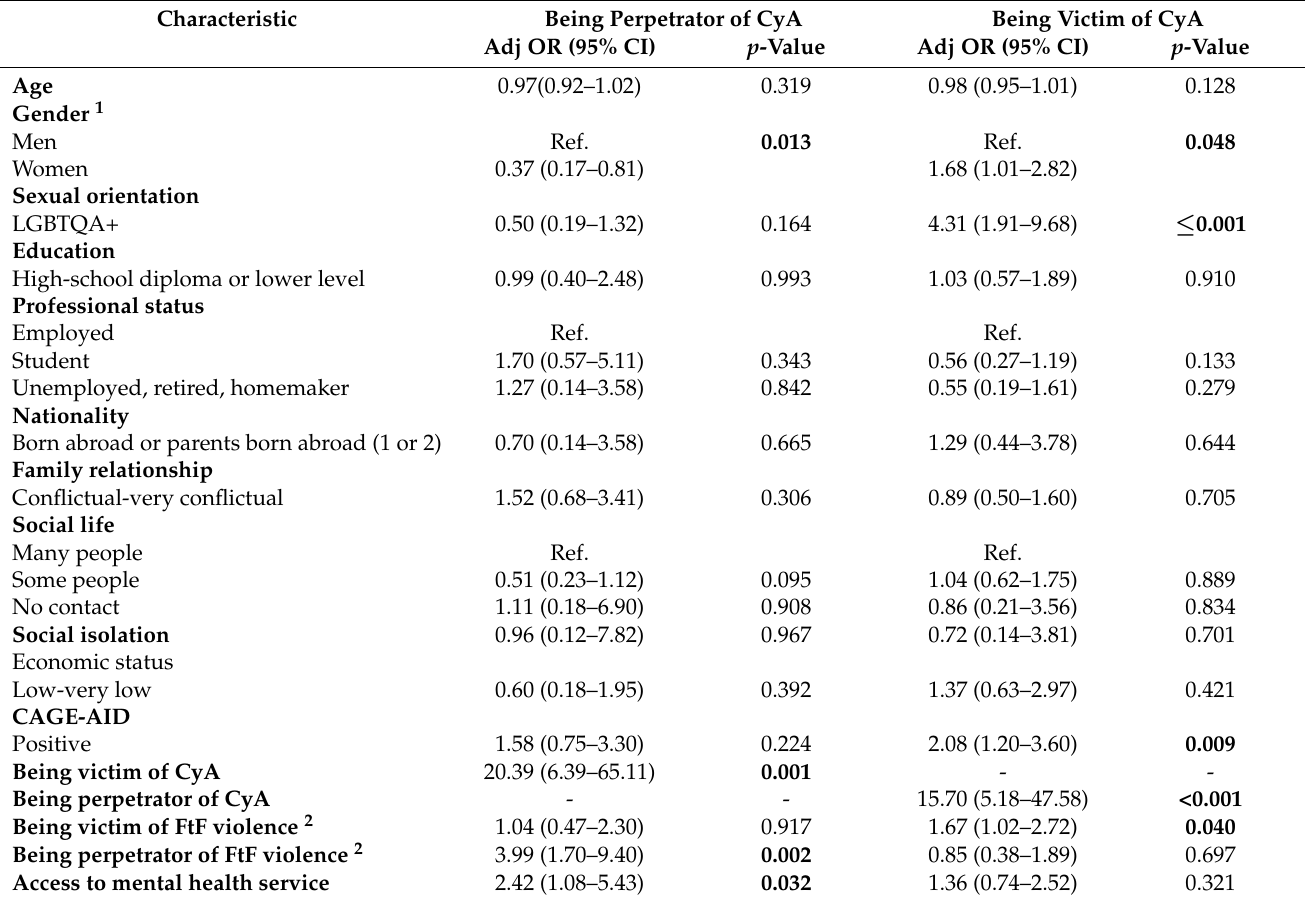
Table 3. Multivariable regressions models of primary